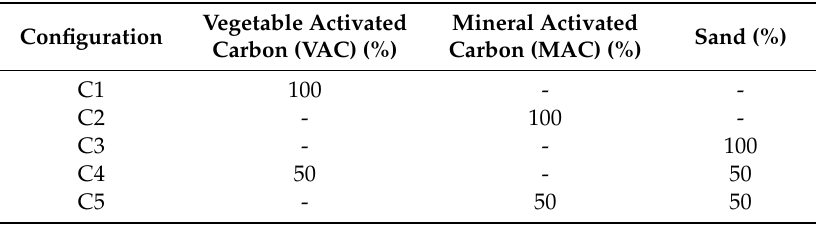
Table 3. Configurations used for the evaluation of sand-GAC filtration. (reprepared using the data from [68]).